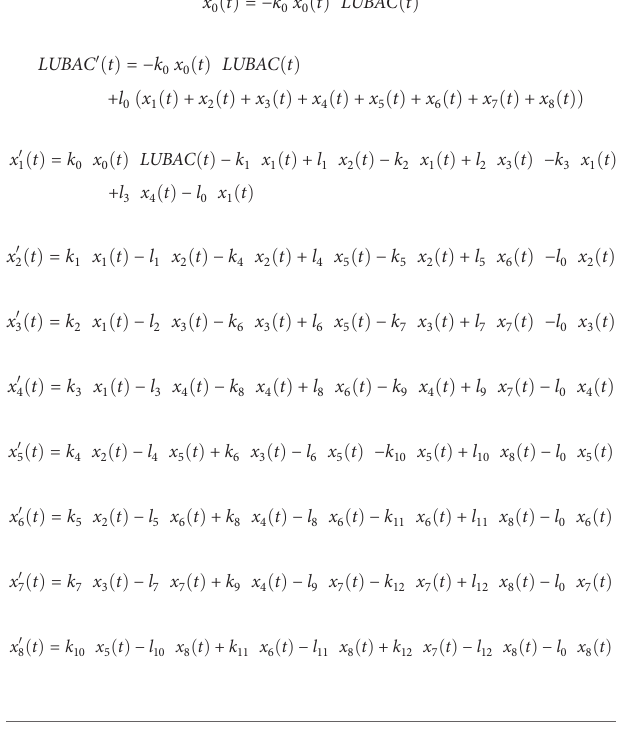
TABLE 2 | Parameters for CBM_DM.